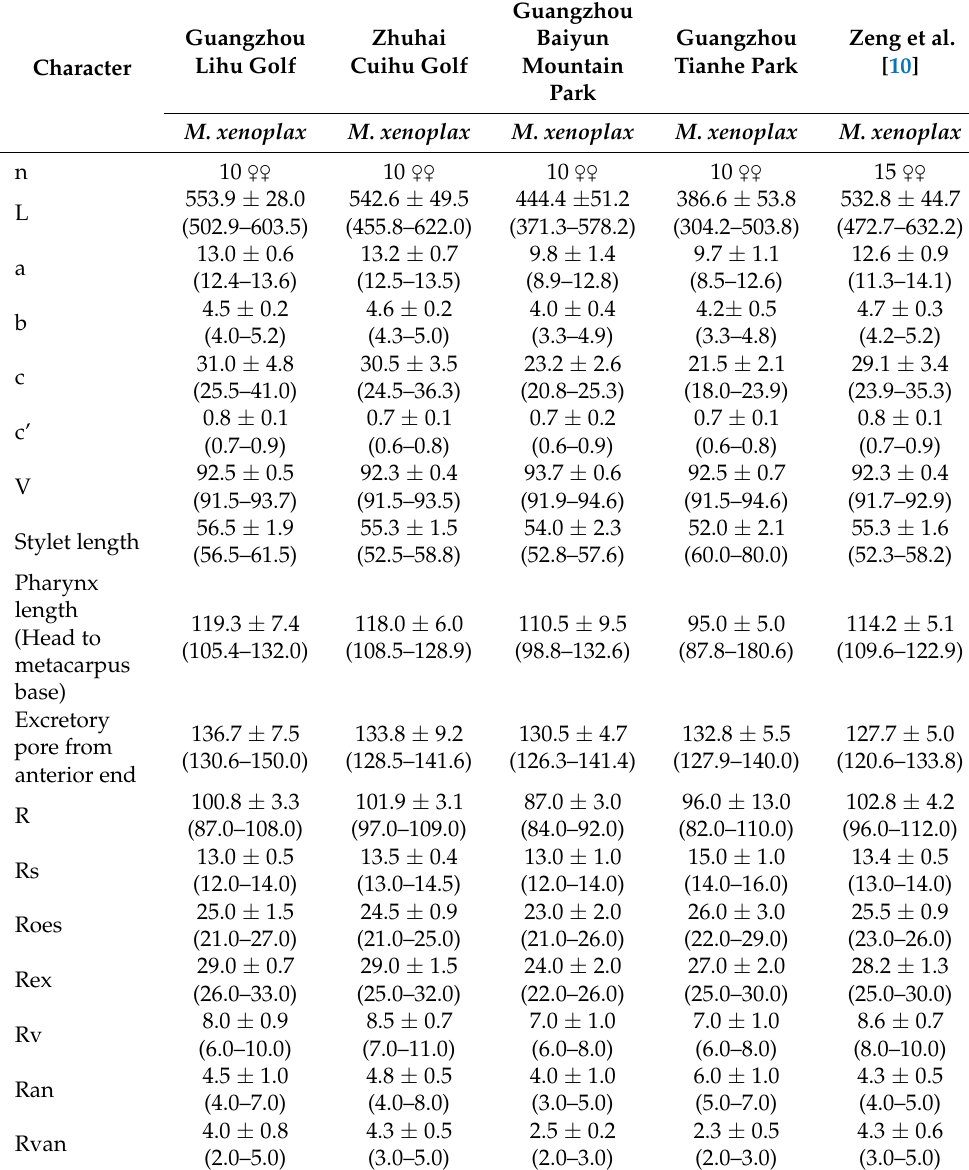
Table 7. Morphometrics of females of Mesocriconema xenoplax populations mounted in formalin– glycerin in this study compared to those reported by Zeng et al. [10]. All measurements in µ m and in the format: mean ± s.d.